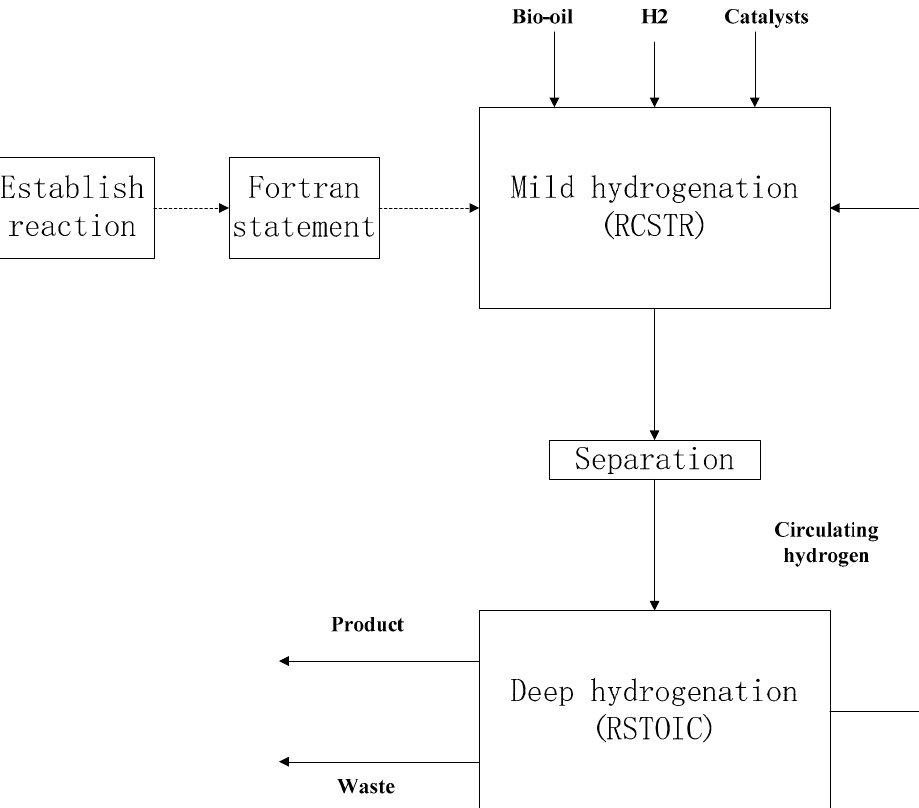
Figure 1. Simulation procedure of the bio-oil hydrogenation (HDO) process.